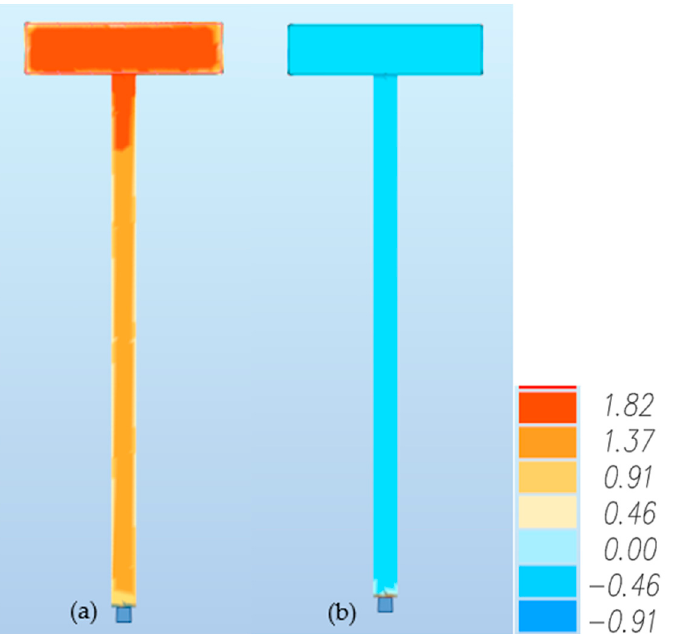
Figure 17. Model created in the calculation program. Maps of the pressure resulting from the applied wind load ( a ) front, ( b ) back.